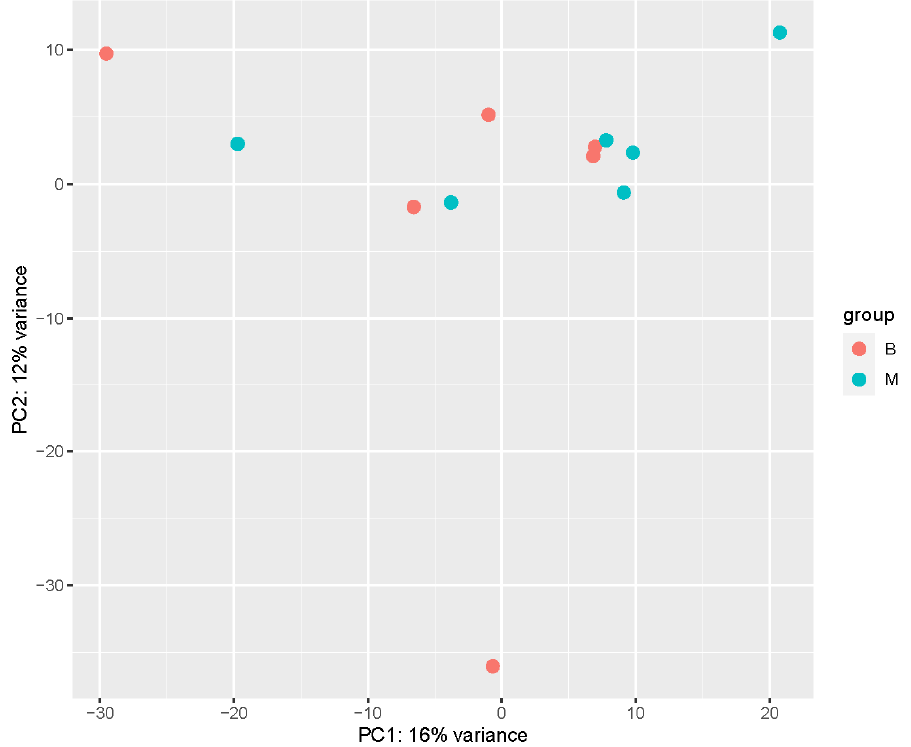
Figure 4. PCA plot. In red (B), embryos that developed to blastocysts after biopsy; in blue (M),